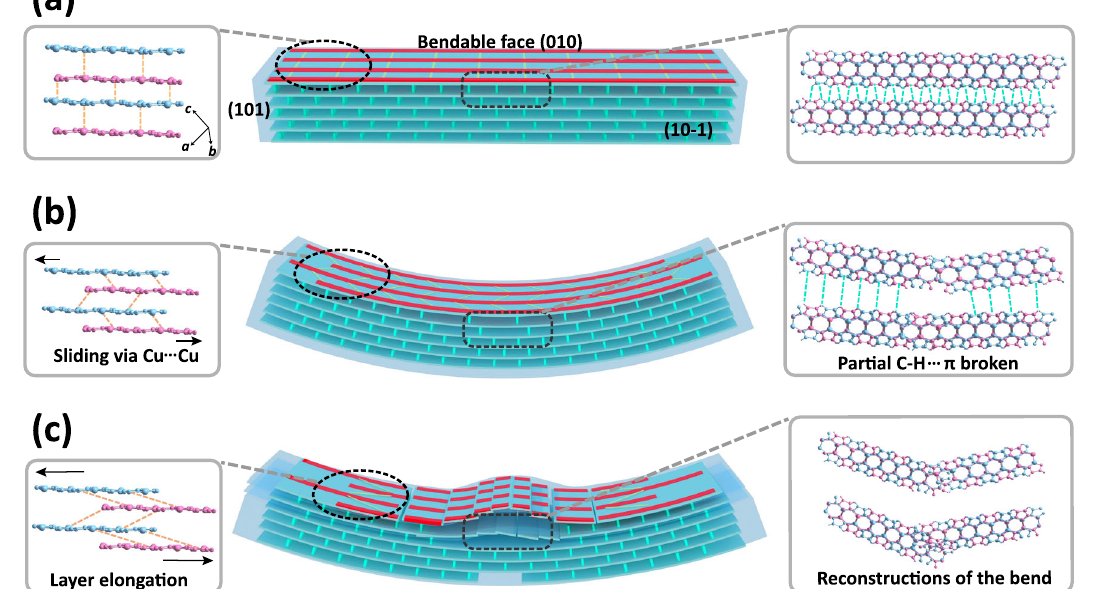
coordinationchains,Cu···Cuinteractions,andtheC – H··· π interactionsbetweenthe layers, respectively.